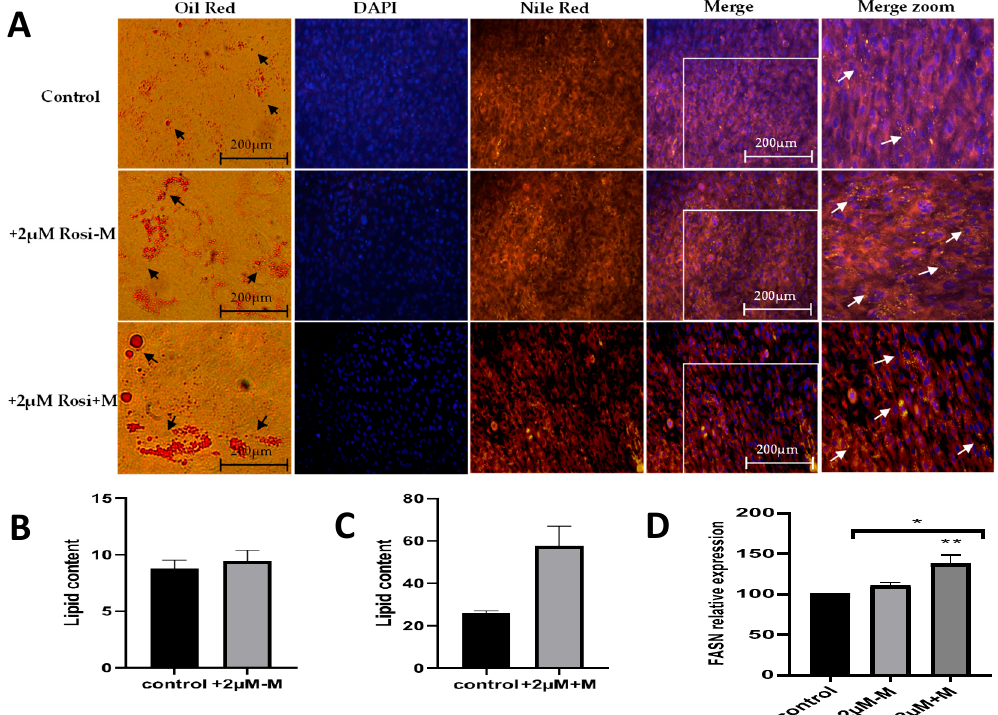
Figure 2. Effect of rosiglitazone on the fatty acid synthesis and lipid content in MSC-derived adipocytes. ( A ) Following differentiation, adipocytes from control, rosiglitazone in induction and rosiglitazone in both induction and maintenance were stained with Oil-O red, Nile red and DAPI stains to observe the increase in the density of lipid droplets accumulation in control, +2 µ M-M, and +2 µ M+M rosiglitazone, respectively. ( B , C ) Mature adipocytes lipid content was determined by eluting the Oil-O red stain and reading its absorbance at 500 nm. ( D ) Expression of fatty acid synthase gene was assessed, and data normalized to GAPDH gene. Data represent mean ± S.E.M. * p < 0.05, ** p < 0.01 versus control.